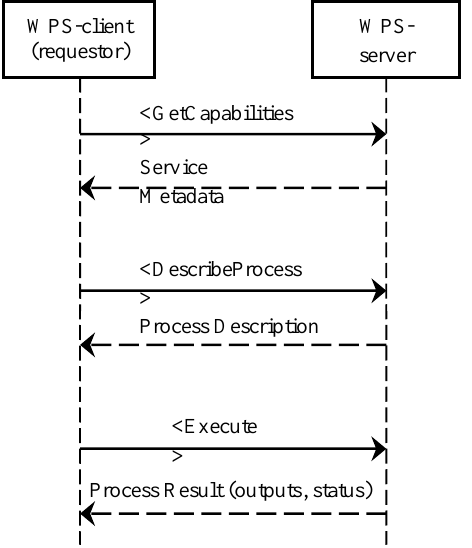
Figure 1. Communication pattern of WPS